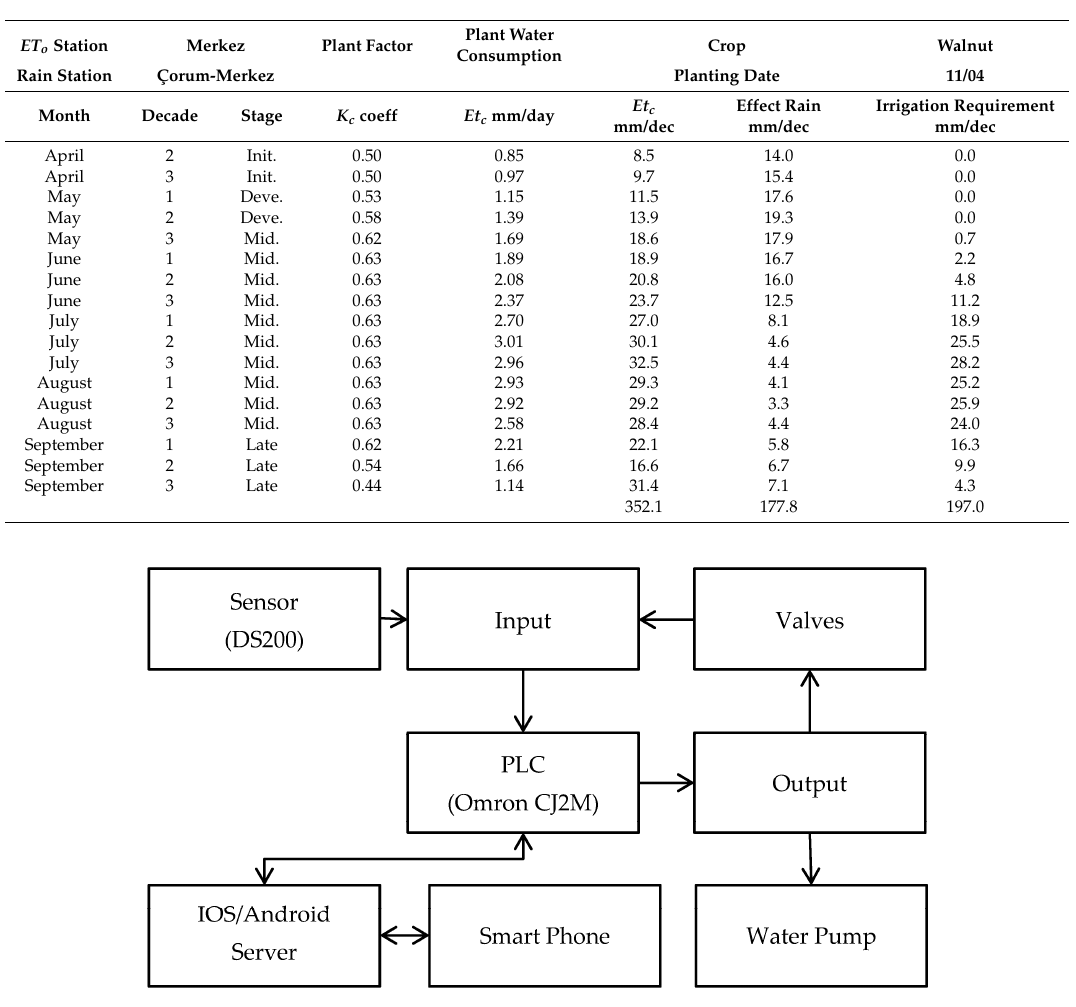
Table 3. Crop water requirements.